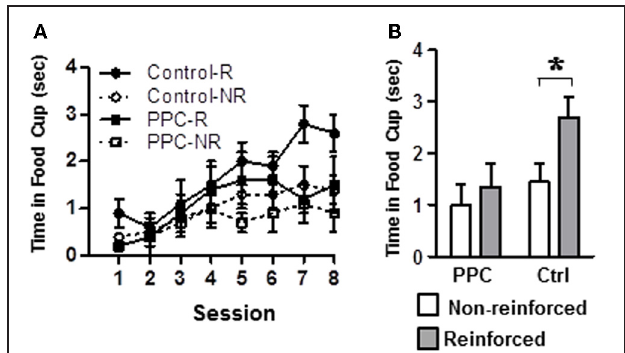
FIGURE 4 | Experiment 2. Damage to PPC impaired learning on the compound feature-negative discrimination task. (A) Conditioned food cup behavior following presentations of the tone-alone (reinforced) and following presentations of the compound stimulus (light-tone, non-reinforced) across all eight conditioning sessions. (B) Combined data from conditioning sessions 7 and 8 during which stable performance is typically observed. Data are mean ± standard error. Abbreviations: R, reinforced stimulus; NR, non-reinforced stimuli. ∗ Indicates a significant ( p < 0 . 05) difference in food cup behavior by control rats on R verses NR